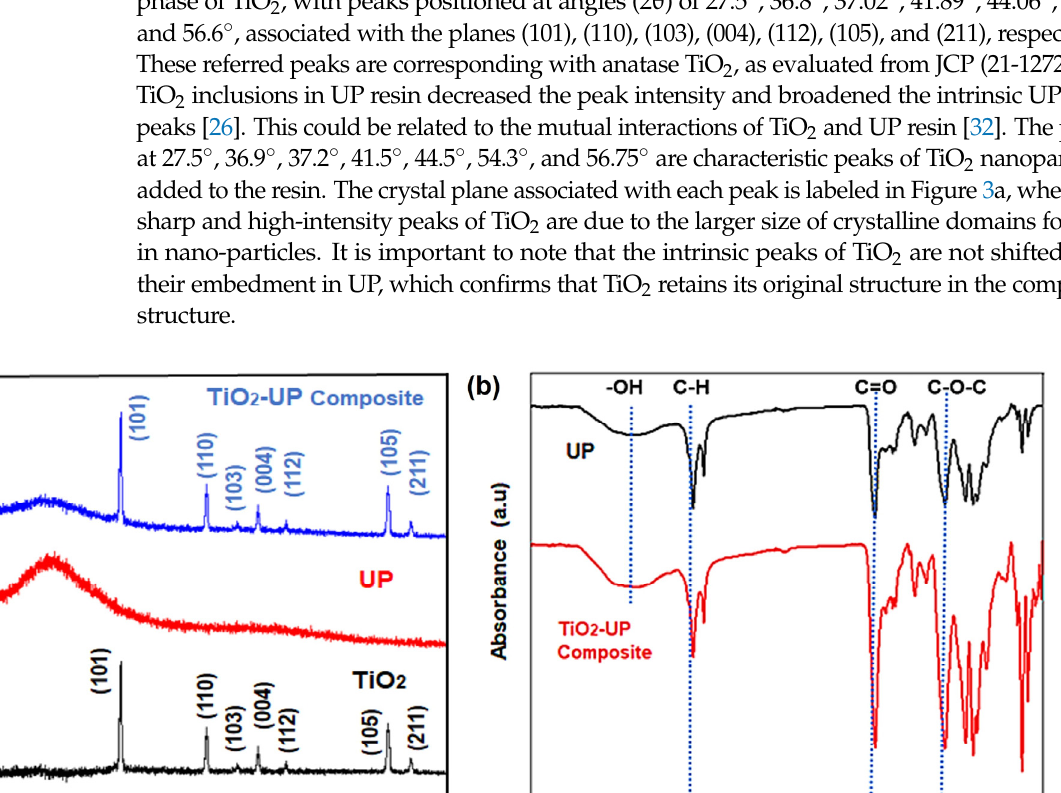
Figure 2. SEM images of the TiO 2 nanoparticles at different resolutions.